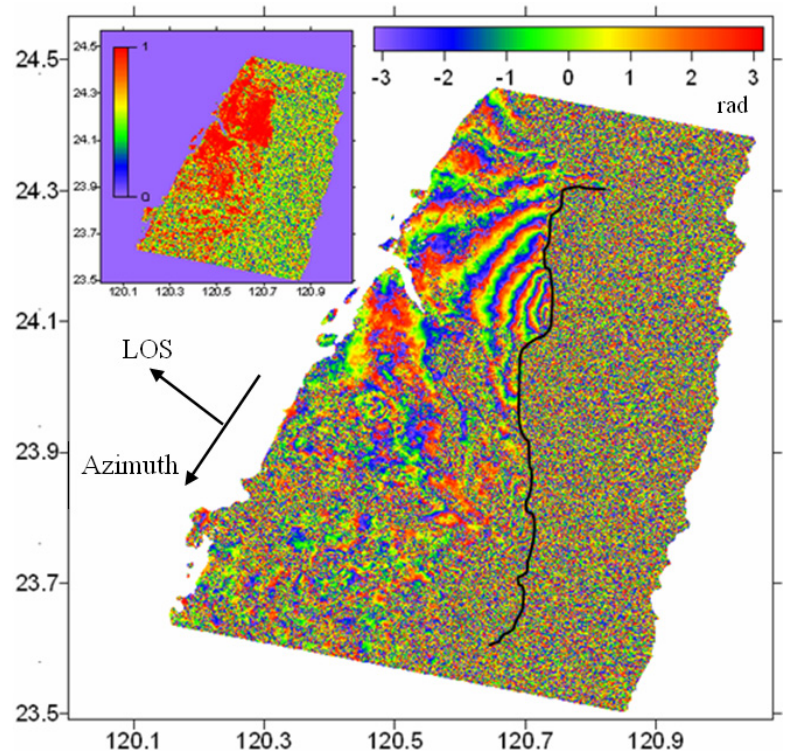
Figure 2. Co-seismic interferogram of Chi-Chi earthquake. Each interferometric fringe represents 2.8 cm of relative displacement in the radar LOS direction. The black line represents the Chelungpu fault. The inset diagram shows the corresponding coherence map. The value zero means that the signals are completely decorrelated and value unity fully